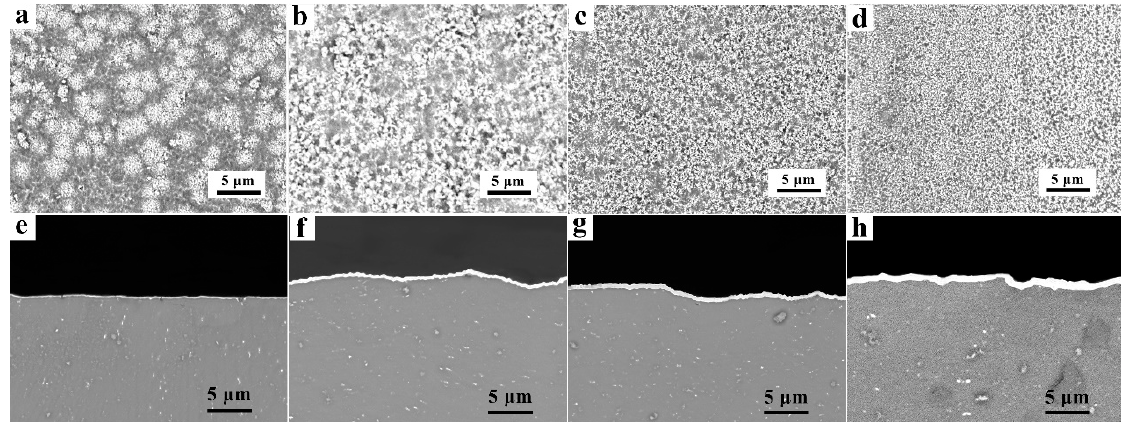
Figure 1. ( a – d ) The SEM planar view and ( e – h ) the cross-sectional morphologies of the Zn layers on the AZ91D Mg alloys with Zn immersion for ( a , e ) 2 min, ( b , f ) 4 min, ( c , g ) 6 min, and ( d , h ) 8 min.